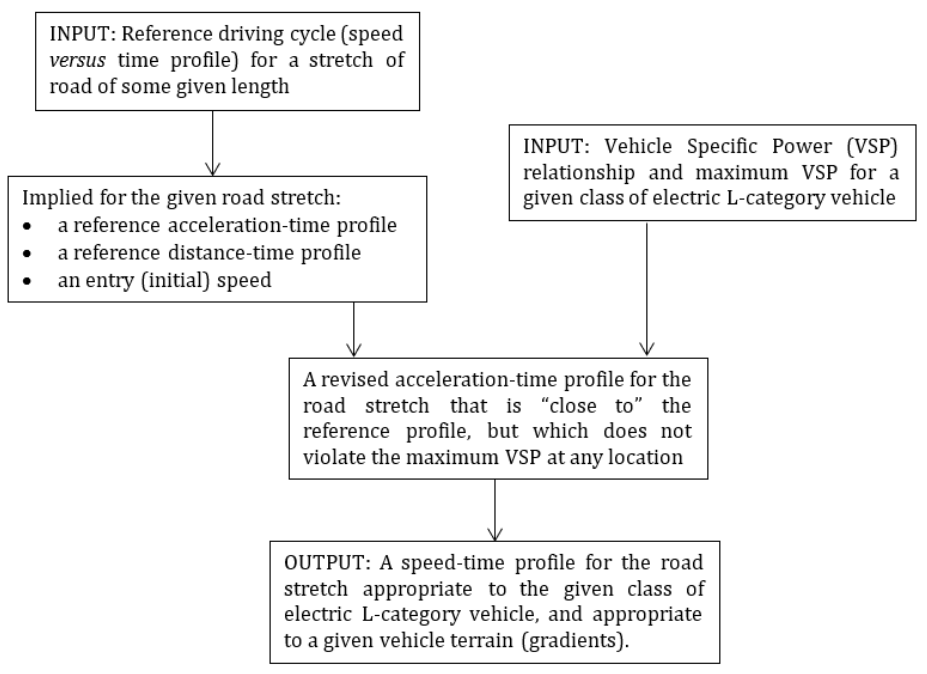
Figure 4. Schematic representation of the applied methodology.